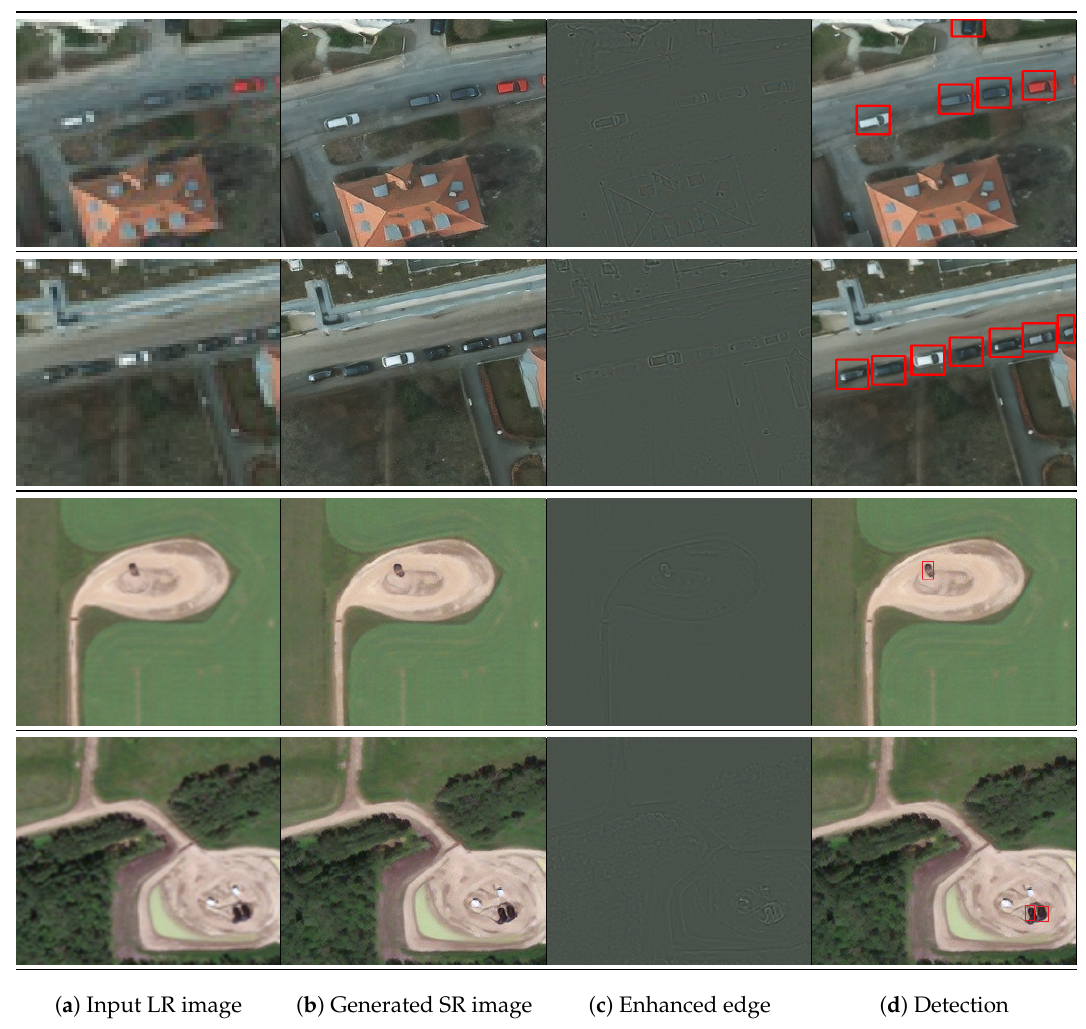
Figure 11. Examples of SR (super-resolution) images that are generated from input LR (low-resolution) images are shown in ( a , b ). The enhanced edges and detection results are shown in ( c , d